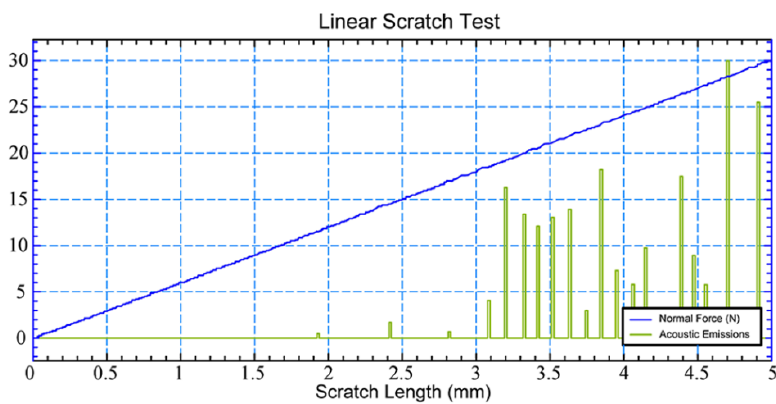
Figure 10. The dependence on the scratch length of the normal force and acoustic emission.